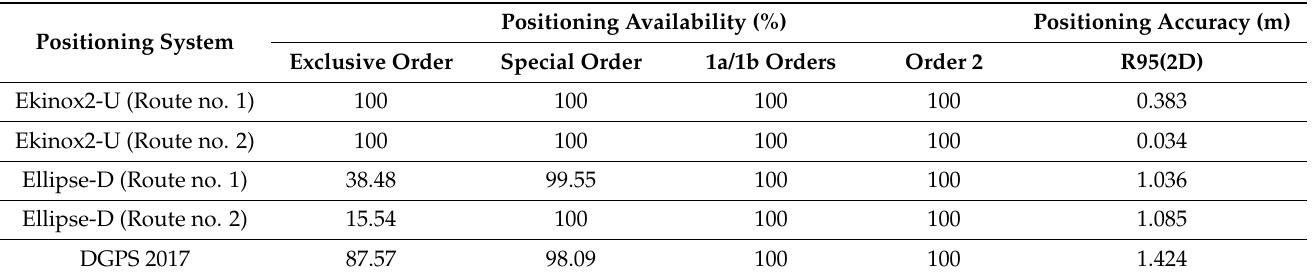
Table 4. The availability factor values determined for the GNSS/INS systems in the context of minimum positioning requirements, set for all IHO orders.